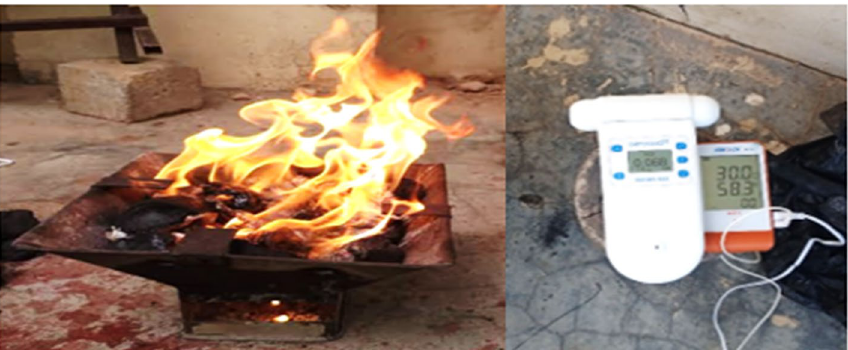
Figure 4. Measurement of combustion indices from a typically loaded charcoal pot ( source: present study,